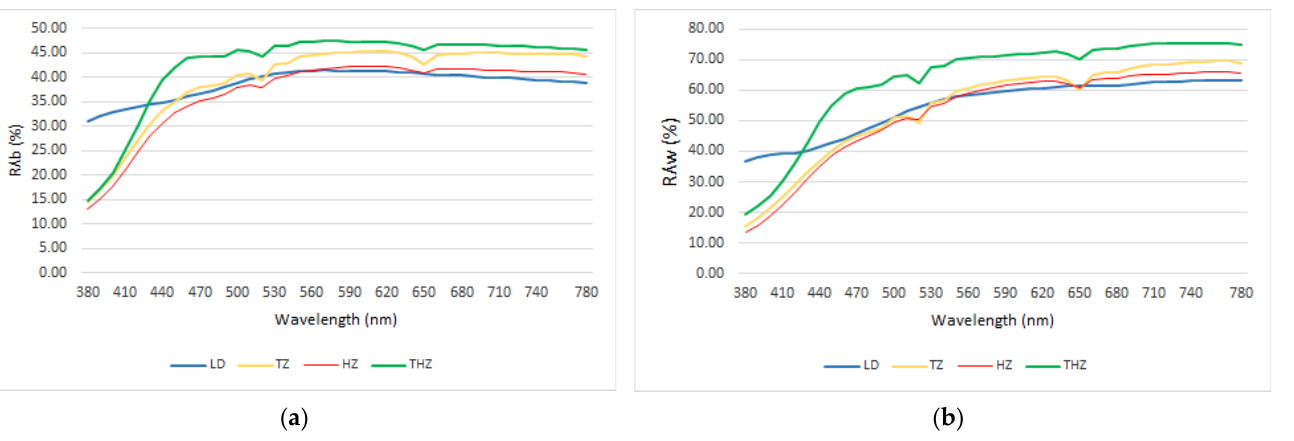
Figure 1. Reflectance spectra of the three samples, as mean of all measurements: ( a ) Reflectance spectra in terms of R λ B ; ( b ) Reflectance spectra in terms of R λ W.